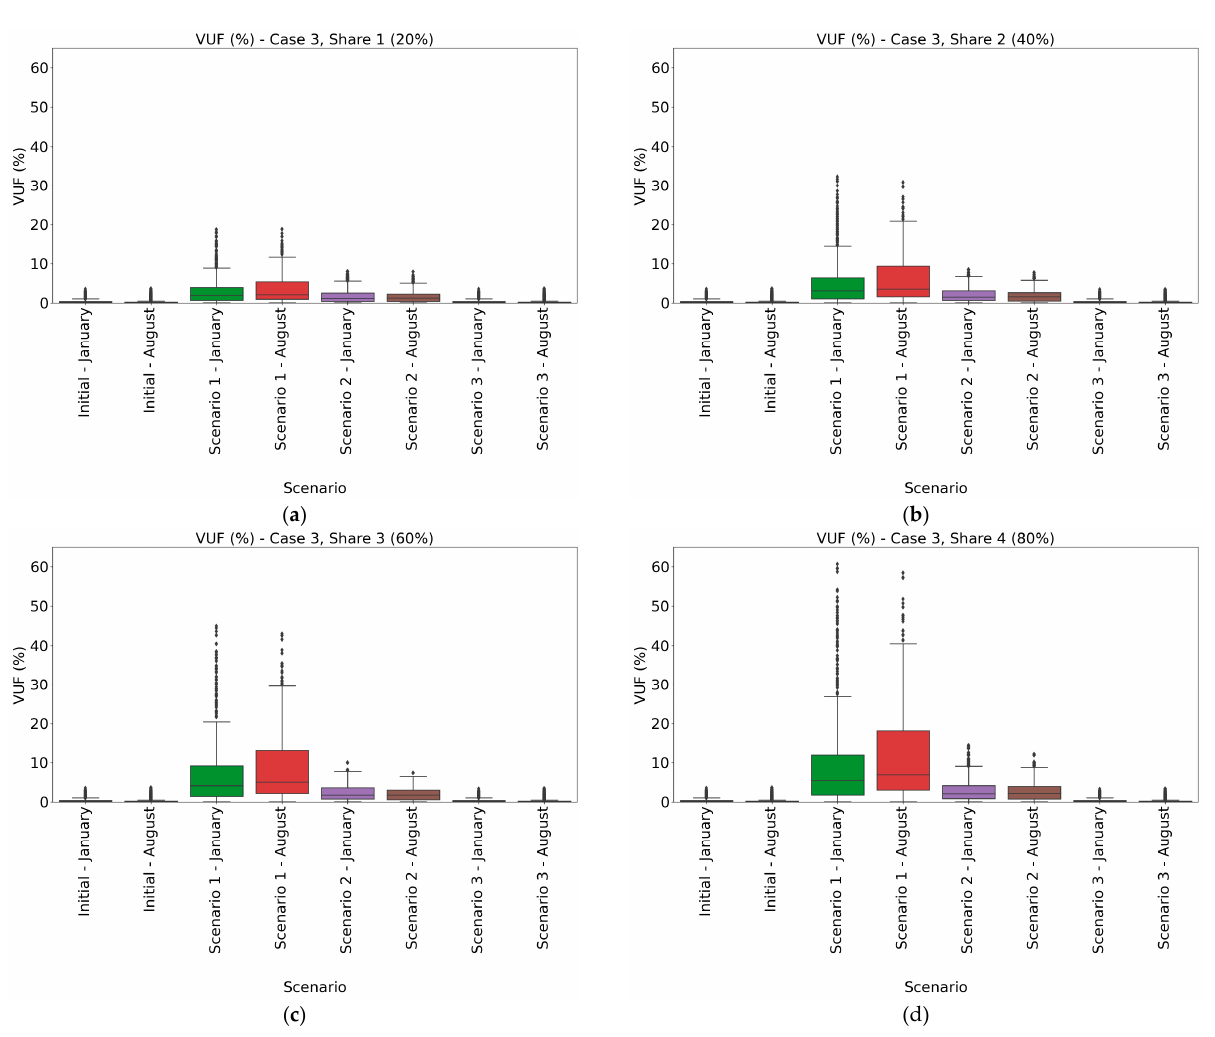
Figure 6. VUF (%)—Case 3; Share 1–Share 4; January,